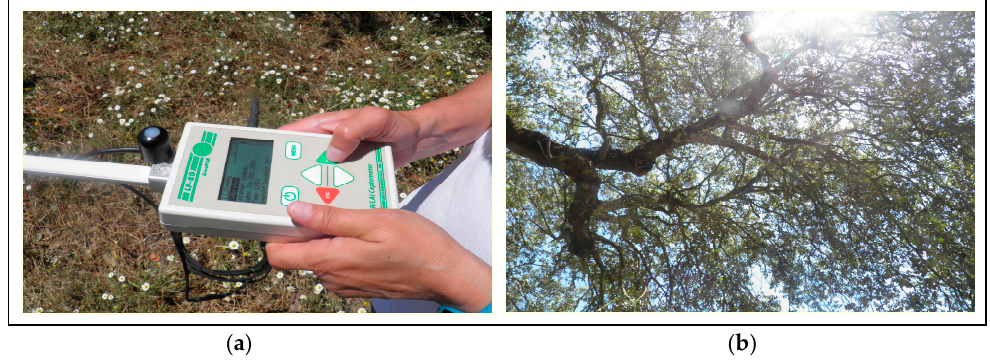
Figure 6. Ceptometer AccuPAR LP-80 ( a ) used to measure the photosynthetically active radiation (PAR) ( b ).